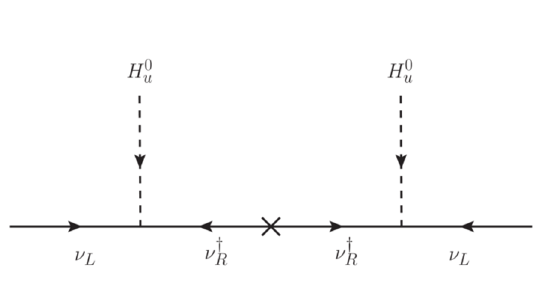
Figure 1 . Feynman diagram associated with the type-I seesaw mechanism. The dimension-5 Wein- berg operator is e(cid:11)ectively generated when the heavy right-handed neutrinos are integrating out.